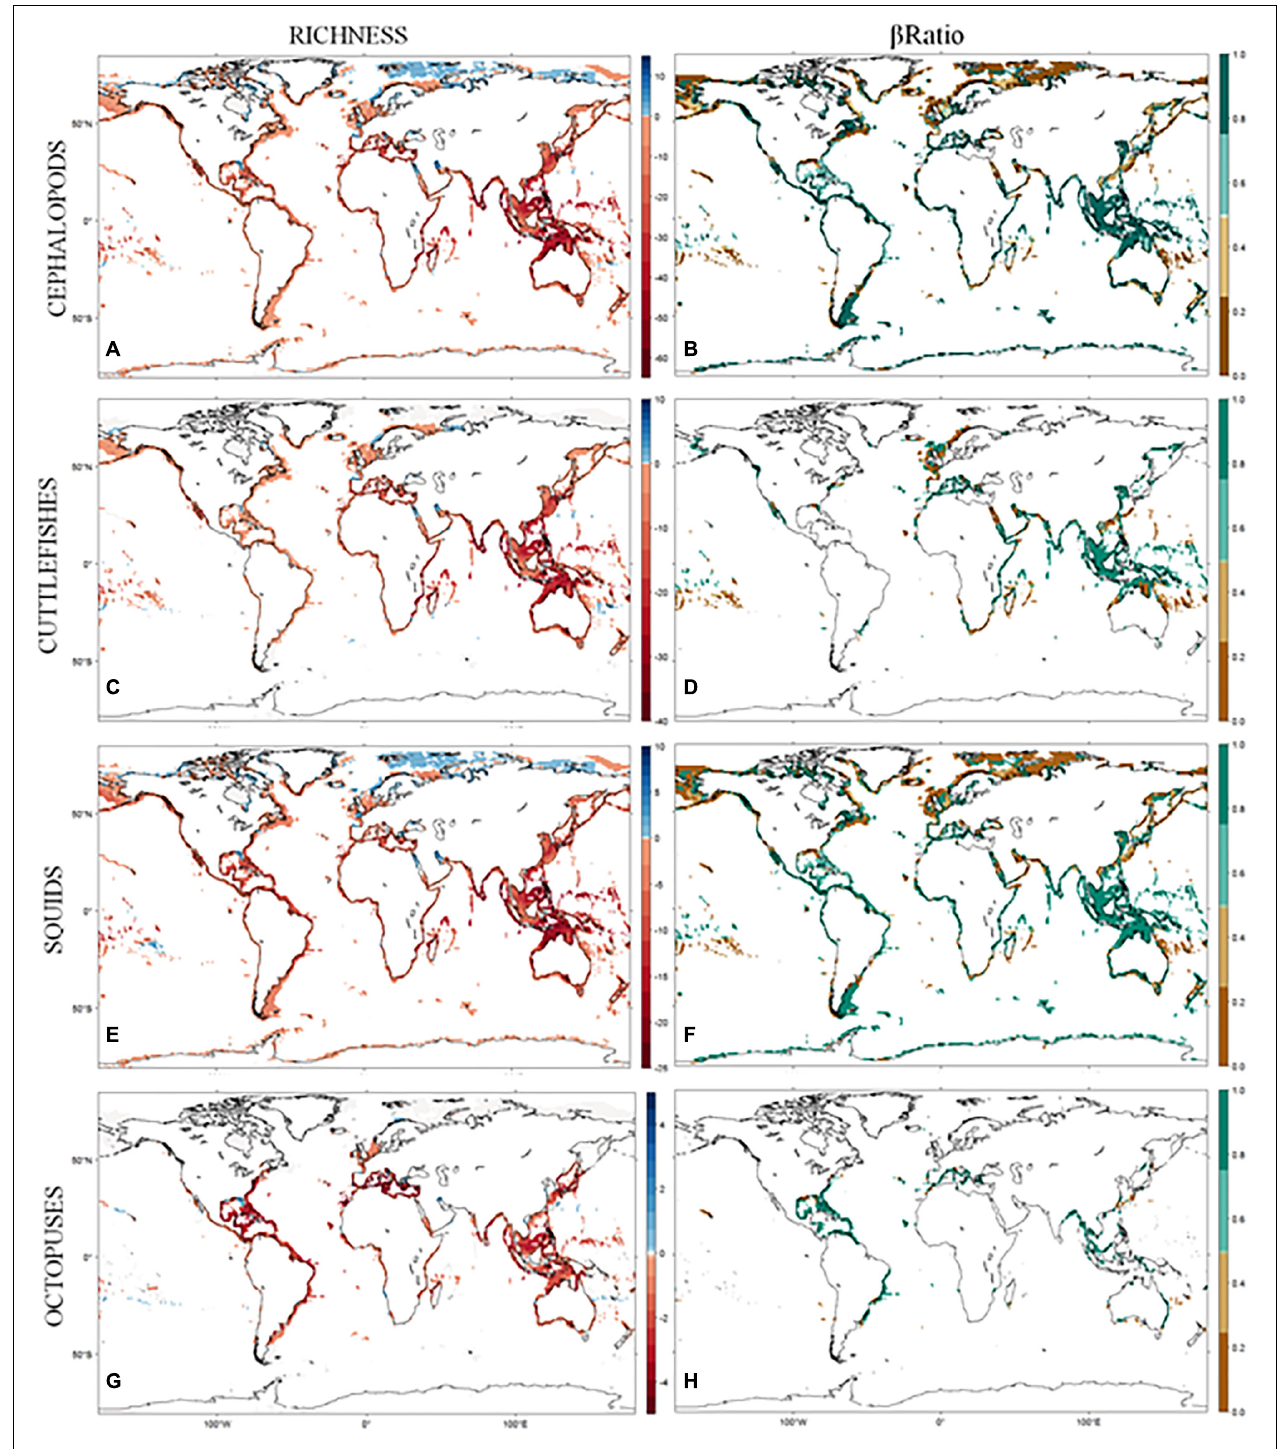
FIGURE 2 | (A–H) Predicted changes in richness and composition between the baseline and the end-of-century period, under IPCC AR5 RCP4.5 scenario, for the coastal cephalopod assemblages. Changes in diversity are quantified using delta richness (DRS) and changes in composition using the β ratio index.